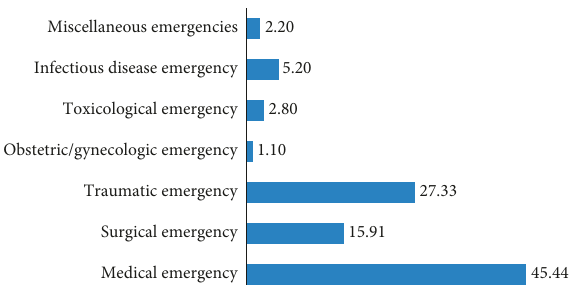
Figure 2: Major kinds of observed emergency conditions in the selected hospitals in Nekemte, western Ethiopia, 2017.